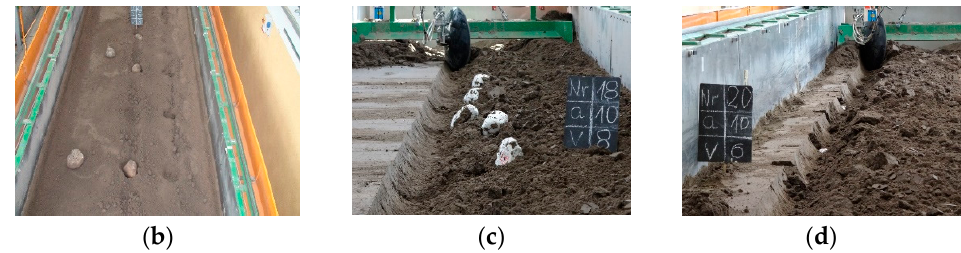
Figure 10. Displaced stones for exemplary working parameters during the operation of the: ( a ) stiff tine ( a = 0.10 m, v = 2.22 m·s –1 ), ( b ) flexible tine ( a = 0.05 m, v = 2.22 m·s –1 ), ( c ) coulter ( a = 0.10 m, v = 2.22 m·s –1 ), ( d ) coulter-axis stones ( a = 0.10 m, v = 1.67 m·s –1 ). These results correspond to greater soil dispersion at higher working depths [10].